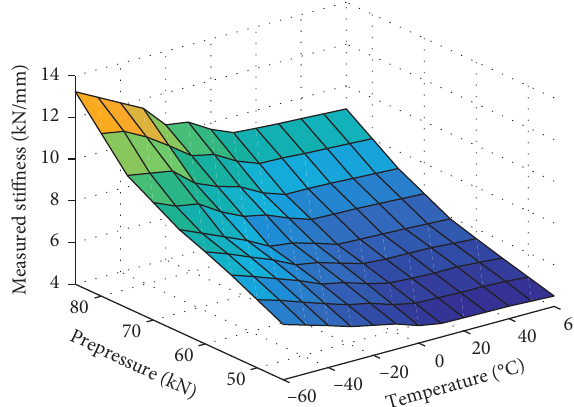
Figure 6: Surface diagram of measured stiffness.